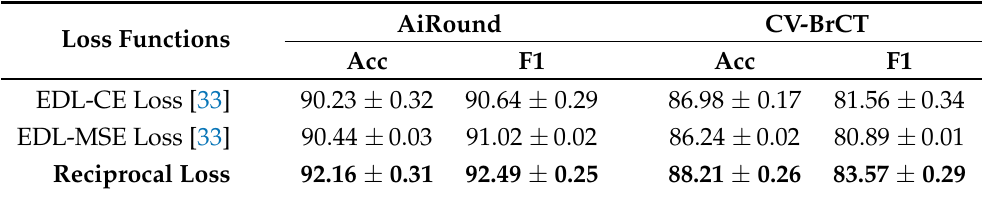
Table 2. Performances (%) ± STD of different loss